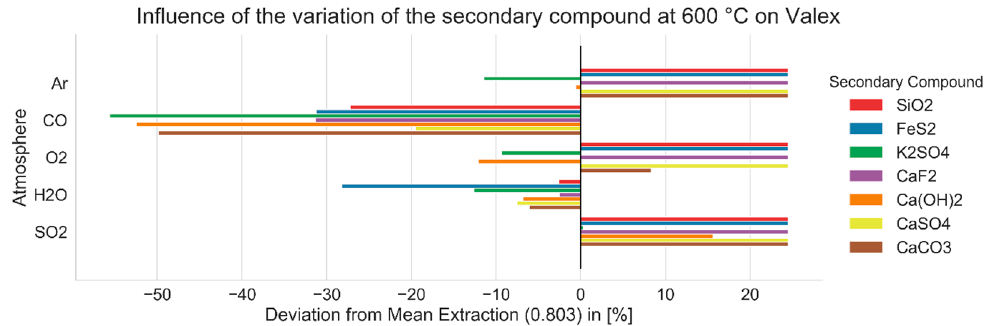
Figure 7. Influence of the variation of atmosphere and secondary compounds on valex rates at 600 °C, 1 atm, and chlorine stoichiometry of 1.